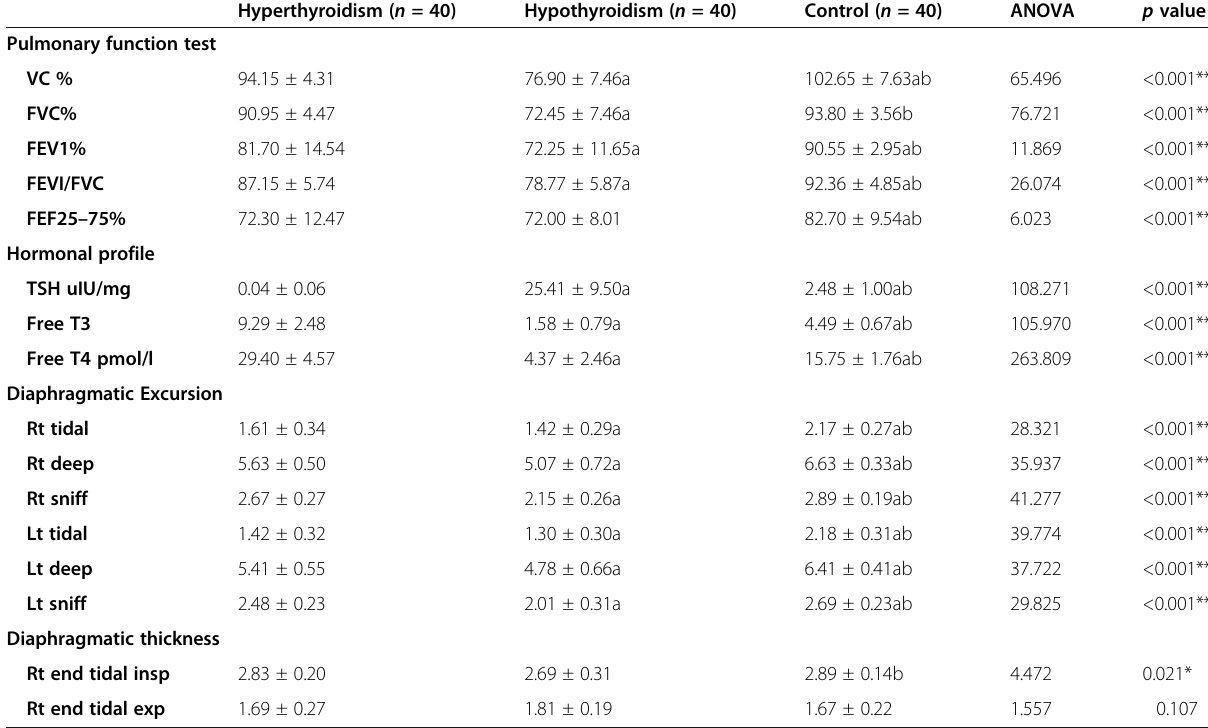
Table 3 Comparison between groups according to pulmonary functions tests, hormonal profile, diaphragmatic excursion, and diaphragmatic thickness Hyperthyroidism ( n =